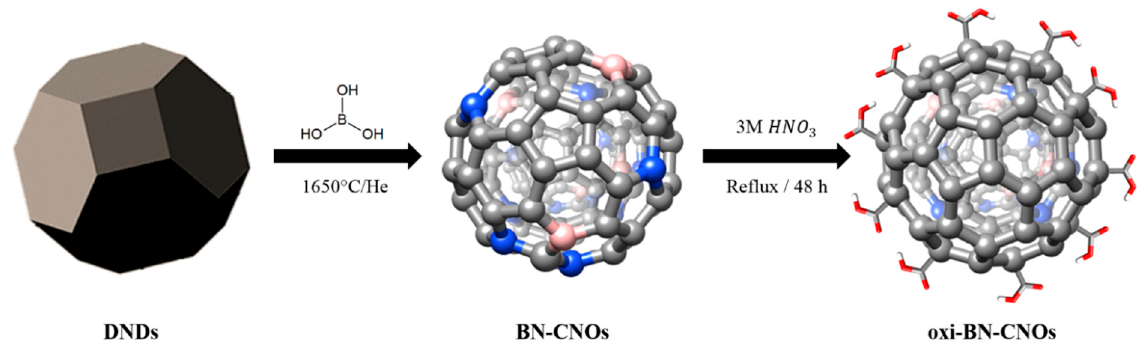
Figure 1. Synthetic procedure for the production of BN-CNOs and